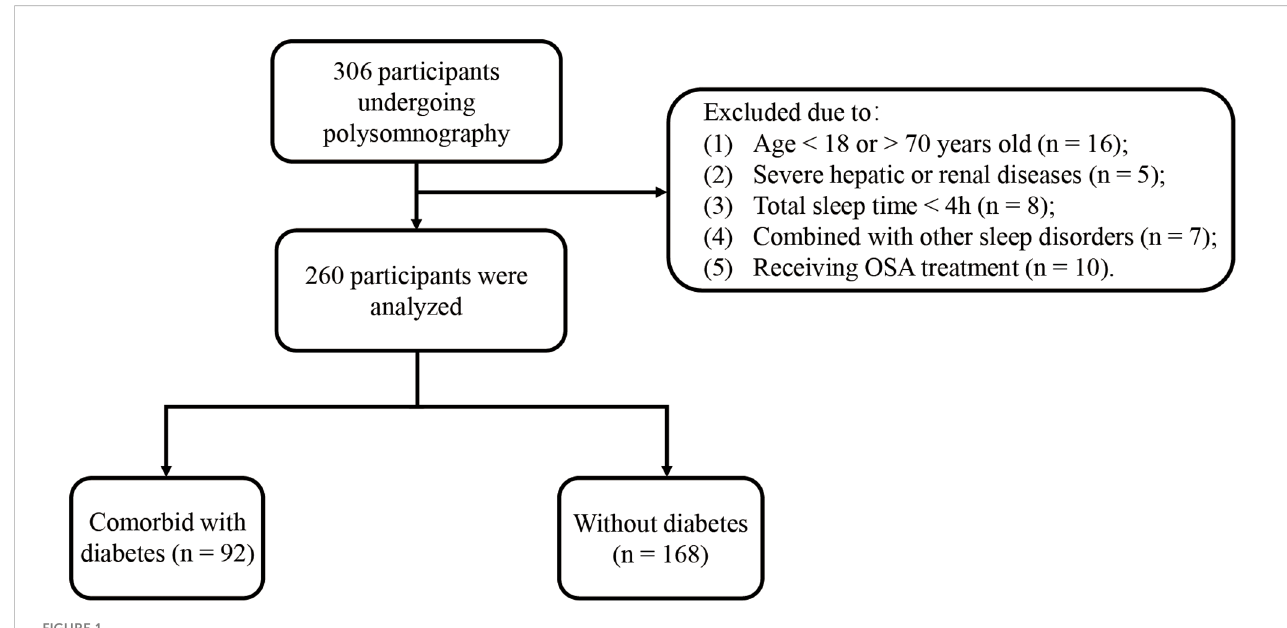
FIGURE 1 Flowchart of the study